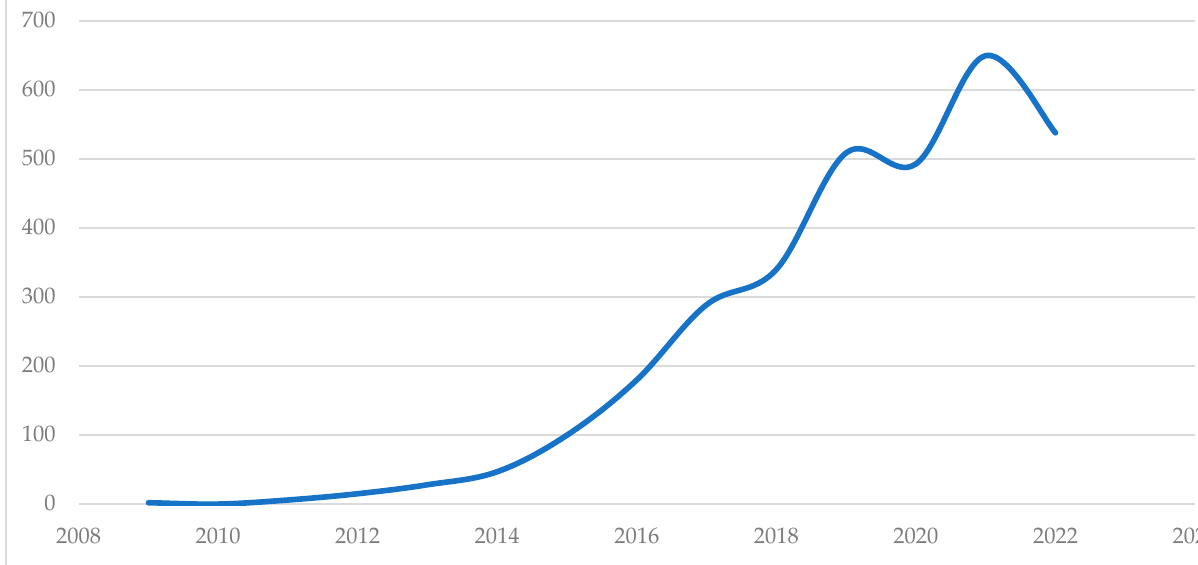
Figure 3. Year of publication of the documents selected for analysis.